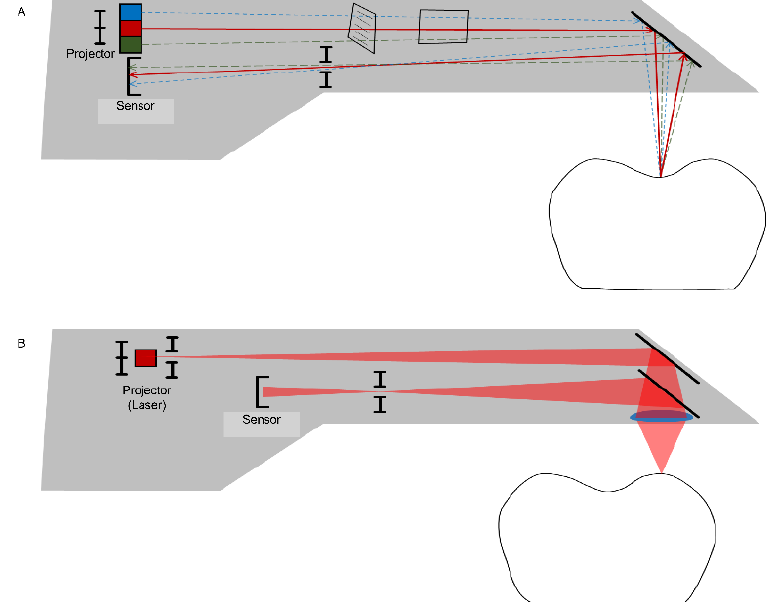
Figure 3. Data-capturing principles for an intraoral scanner use a variety of techniques, such as active triangulation ( A ) and confocal (laser) microscopy ( B ) to create a focus distance within the limited space of the probe.